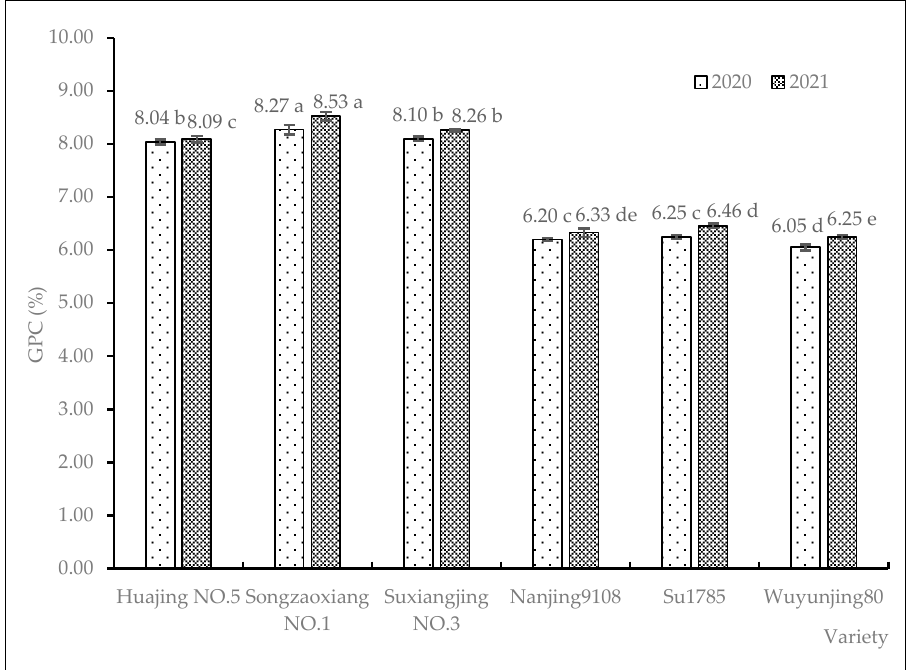
Figure 1. GPC of tested varieties in 2020 and 2021. Different lowercase letters after values indicate a significant difference at the 0.05 probability level.